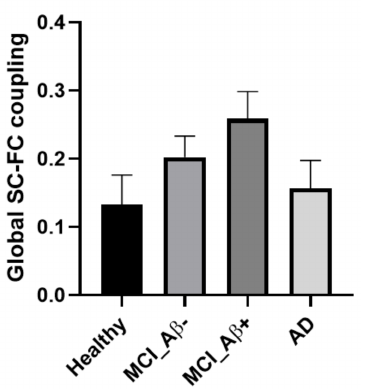
Figure 2. Scatter plot between MoCA score and the whole-brain A β deposition (partial Pear- son correlation controlling for age, sex and Fazekas score). A β : amyloid beta; MoCA: Montreal Cognitive Assessment.